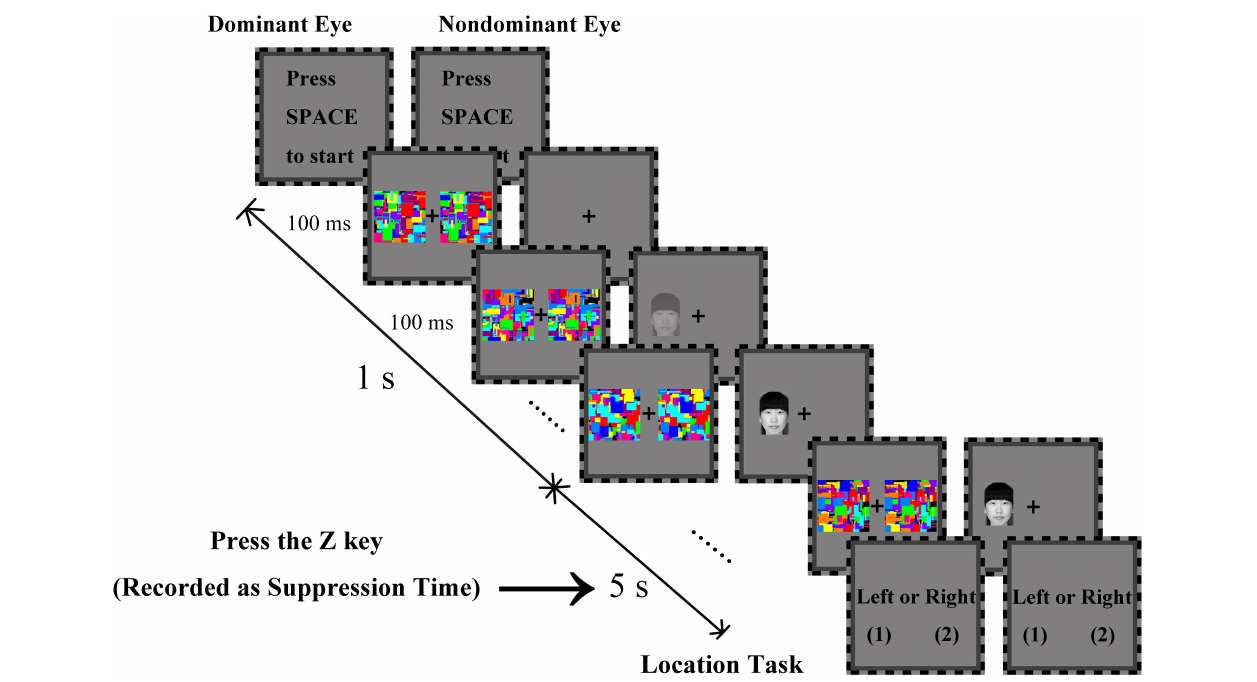
FIGURE 2 | Procedure of Experiment 1 and Experiment 2. Chromatic noises (frequency 10 Hz) were presented to the dominant eye. Faces were presented to the non-dominant eye, and they appeared randomly on the left or right side of the fixation. The transparency of the face linearly decreased from 100 to 0% over the span of 1 s and subsequently remained constant for the next 5 s until the participant responded. The participants were instructed to press the Z key as soon as any part of the face was detected. The stimulus disappeared, and the location task was then presented until the participant pressed the Z key or did not respond within 6 s. To facilitate understanding, the minimum transparency of the faces was